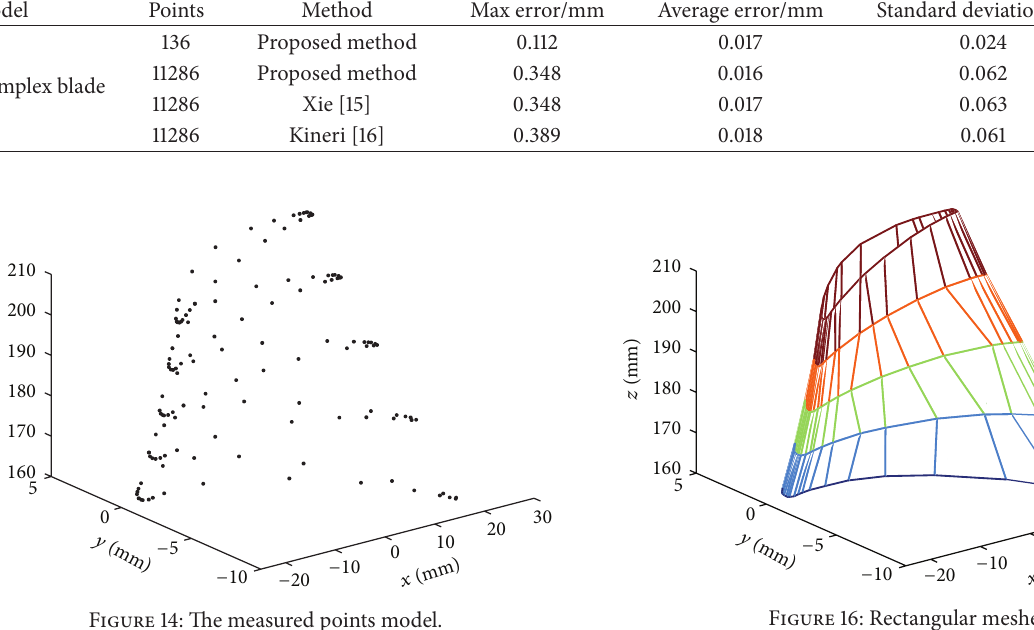
Figure 16: Rectangular meshes.